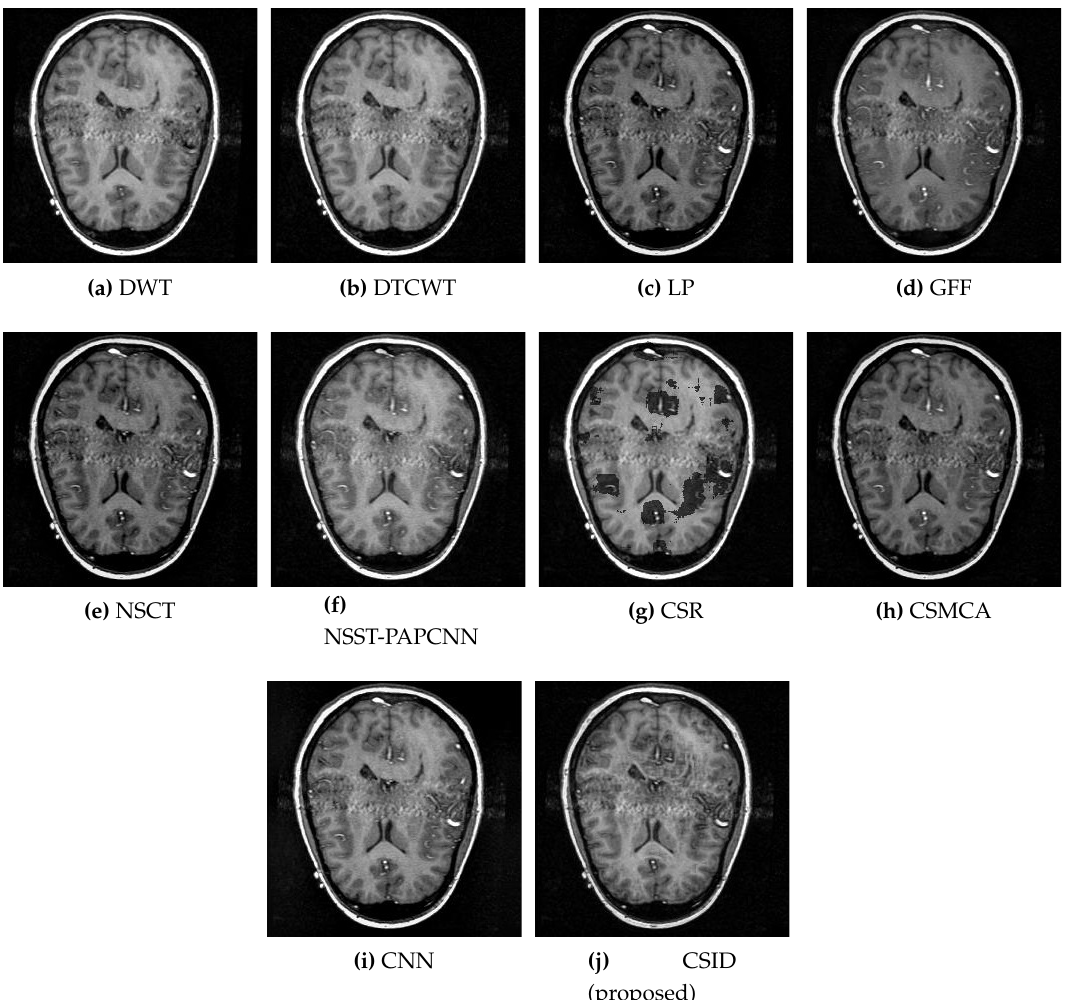
Figure 10. Comparative analysis, based upon visual observation, of the resultant fused images generated by the given set of algorithms using Data-6